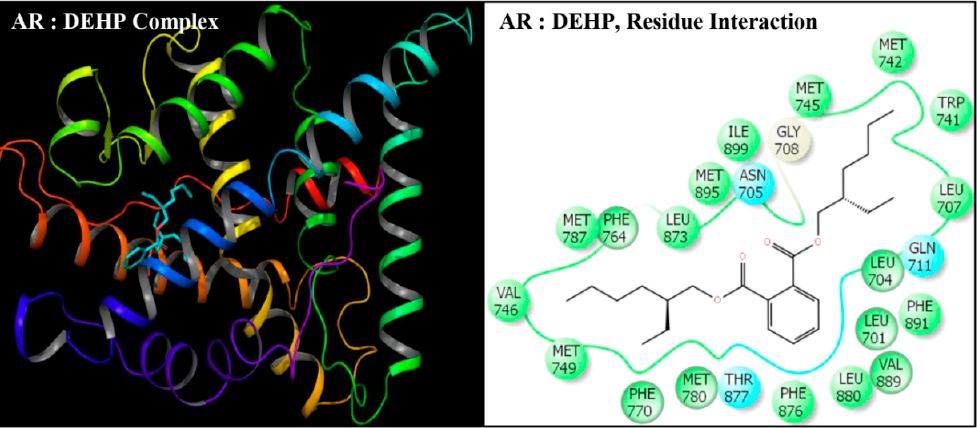
Figure 2. Ribbon diagram representing the docking pose of human androgen receptor (AR) with di(2-ethylhexyl) phthalate (DEHP) (left panel). The interactions of ligand (DEHP) with amino-acid residues in the binding pocket of AR (right panel).